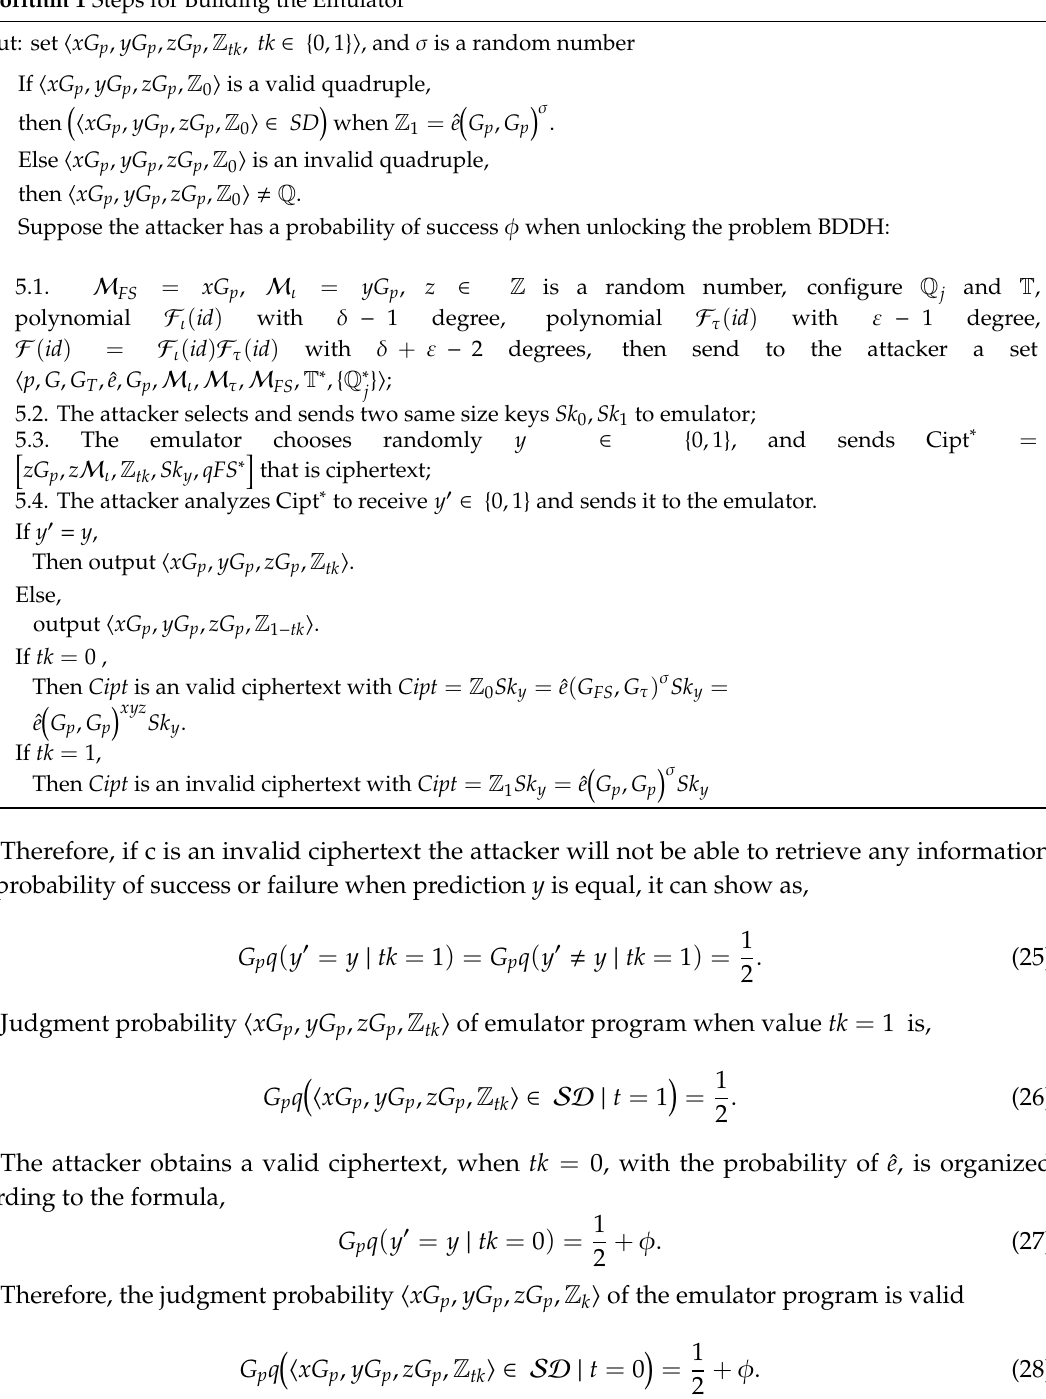
Algorithm 1 Steps for Building the